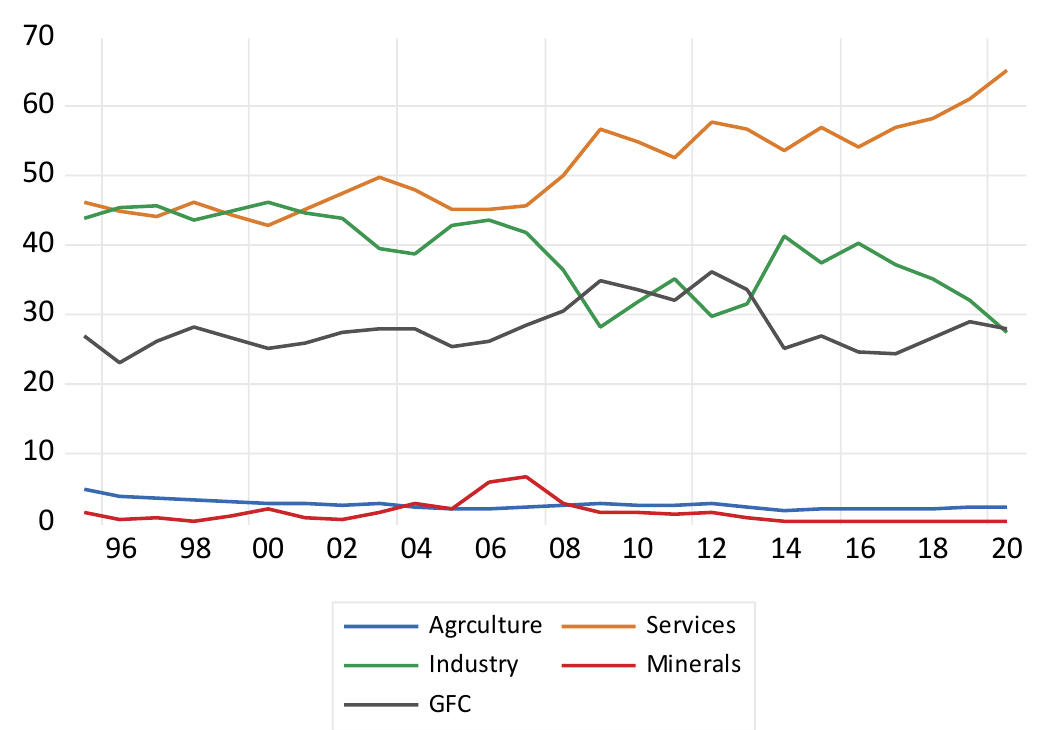
Figure 1. Sectors’ contribution to GDP in percentages, 1995 to 2020. Note: Agriculture is a proxy for the indicator agriculture, forestry, and fisheries. This will be used similarly on several figures and tables. Source: Authors’ computations from World Bank database [16].